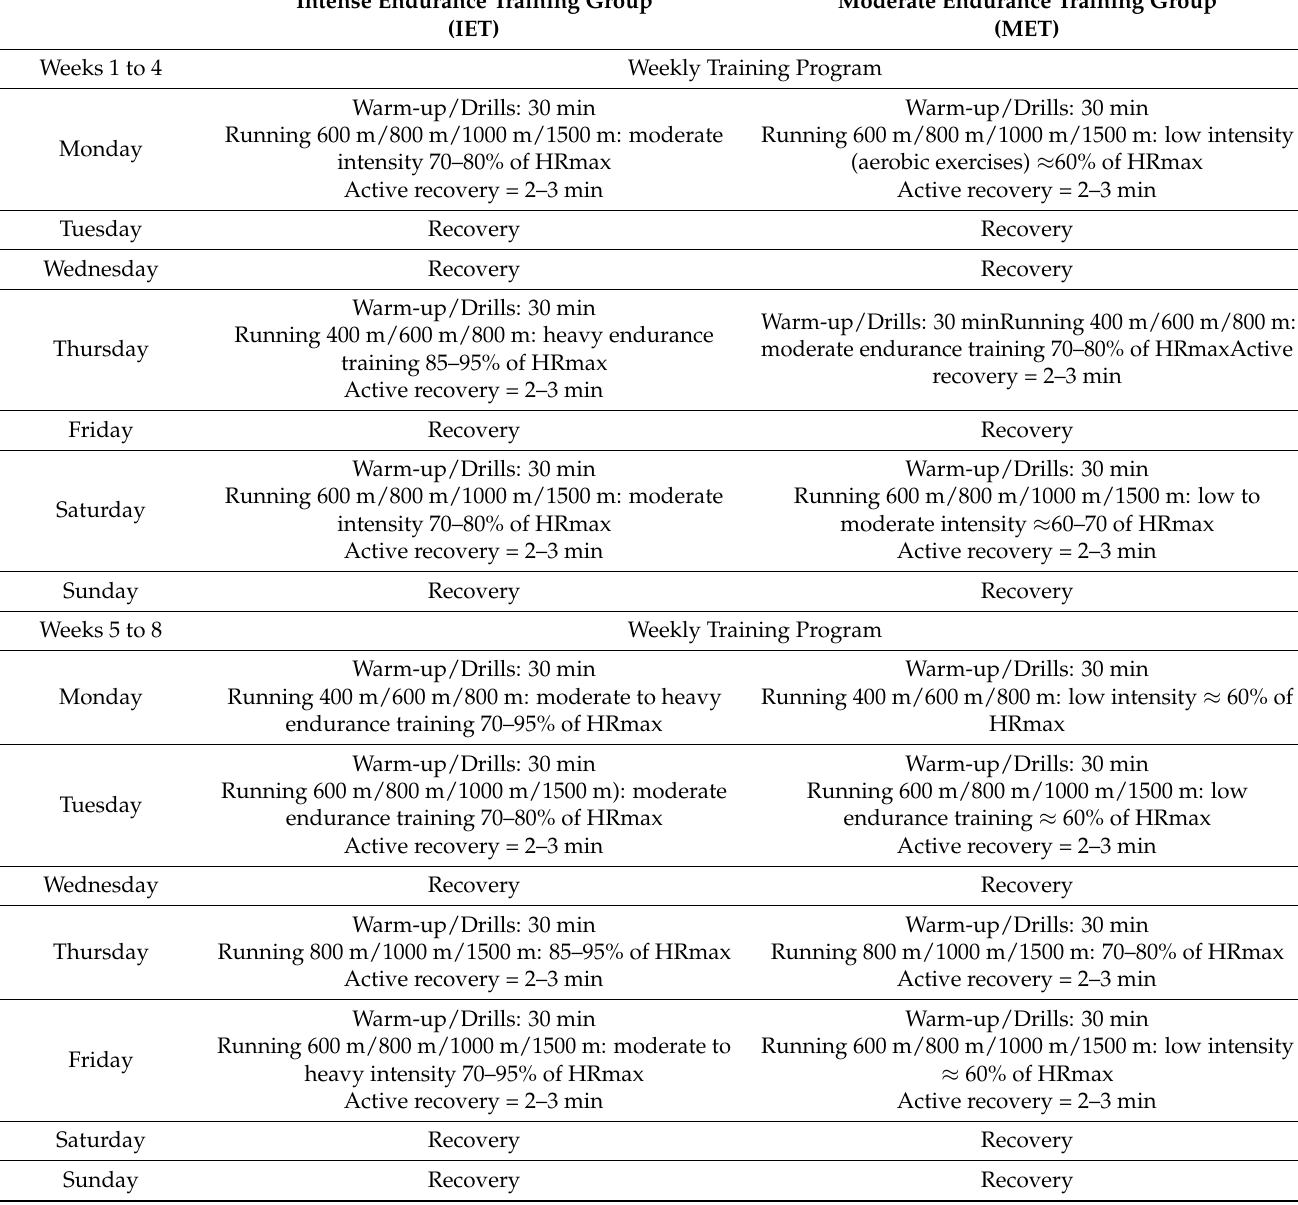
Table 2. Training programs for intense endurance training group (IET) and moderate endurance training group (MET). Intense Endurance Training Group Moderate Endurance Training Group (IET) (MET) Weekly Training